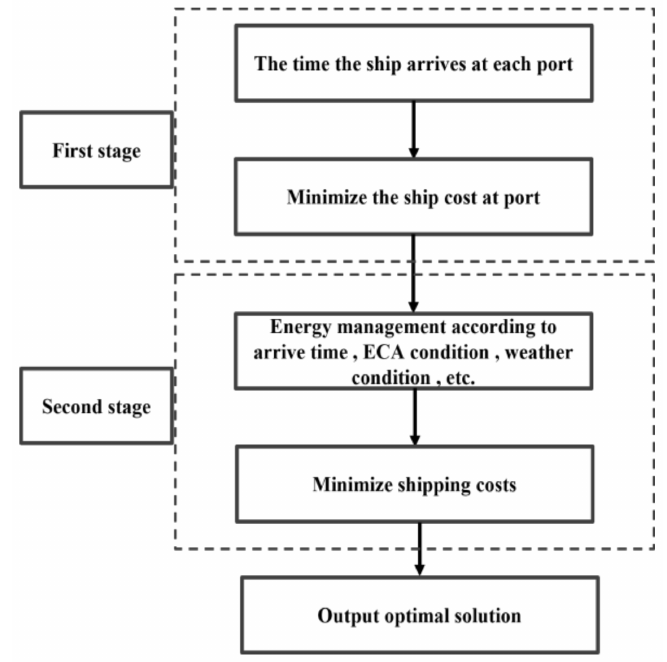
Figure 3. Flowchart of two-stage joint optimization